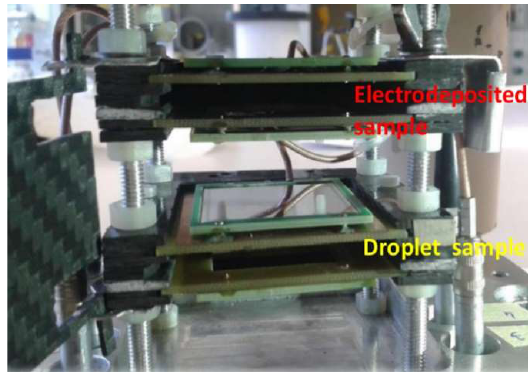
The wide energy range covered by the n-beam